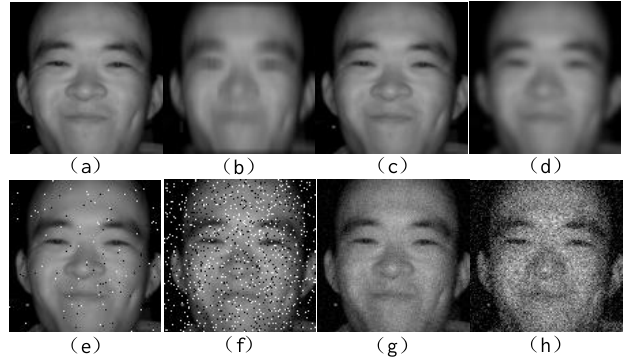
Figure 5. Images of one participant in Test Sets 2–9: ( a )–( h ) are the images in the datasets 2–9, respectively.